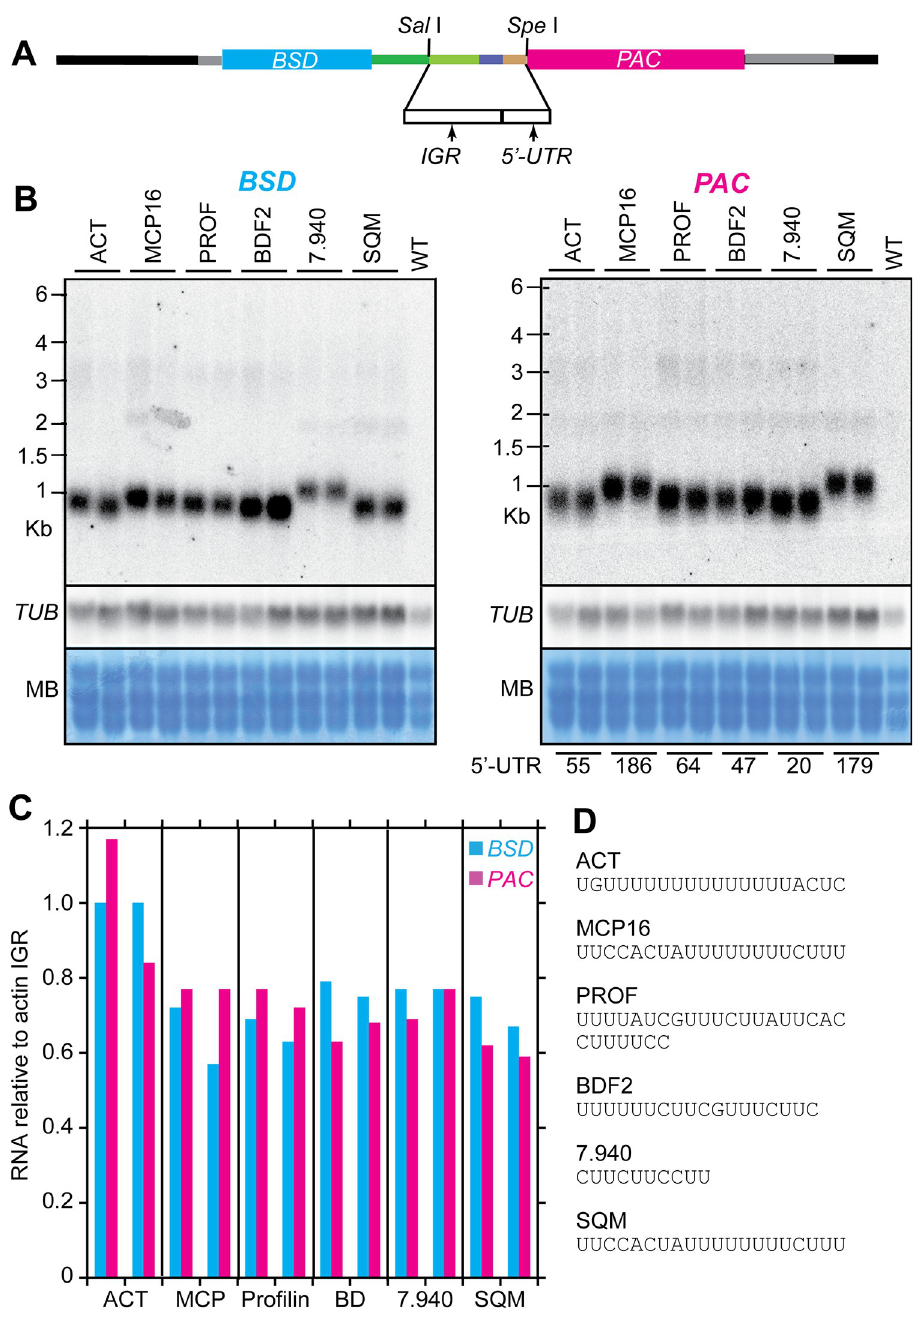
Fig 3. Different intergenic regions and 5’-UTRs. A. Cloning scheme showing positions of the tested sequences. B. Northern blots as in Fig 1C and 1D. The blot was hybridized with a beta-tubulin probe for normalization. Results of two different populations were used. The predicted 5’-UTR lengths are noted below the lanes. C. Amounts of mRNA, obtained by scanning the Northern blot images. Amounts were calculated for two different Northern blots for each population and normalized to the tubulin signal. D. Polypyrimidine tracts upstream of the splice sites. The full sequences are shown in S1 Text.